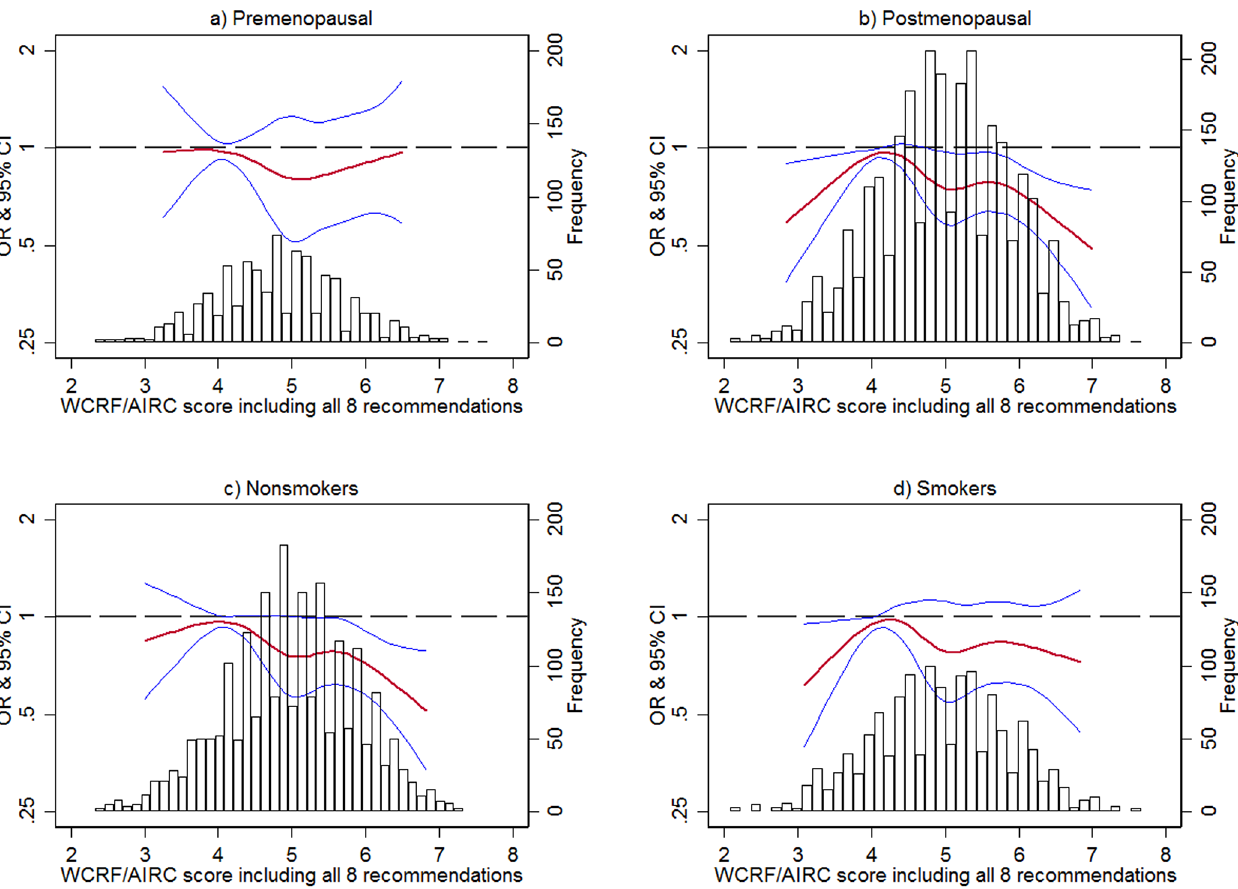
Fig 1. Dose-response shape (natural splines) of the association between the WCRF/AICR score and MD stratifying by menopausal status and smoking habit. The first quintile of the score has been taken as reference.